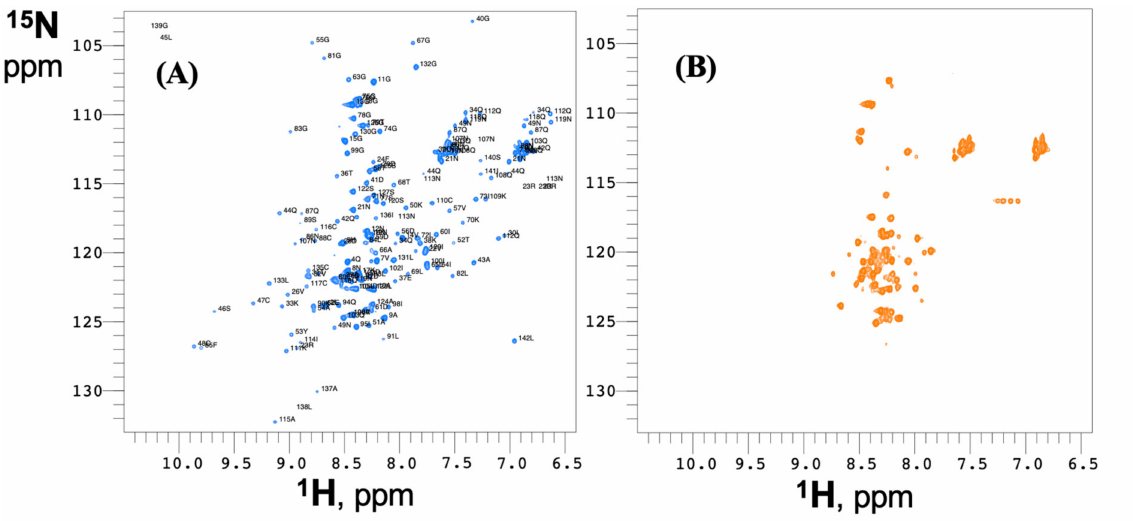
Figure 1. 1 H- 15 N correlation spectra (HSQC) spectra of ( A ) folded RodAp and ( B ) reduced RodAp. In ( A ), the residue and number of each backbone amide correlation is shown. Spectra were recorded at 25 ◦ C in 20 mM sodium acetate bu ff er (pH 4.3) with 5% D 2 O. To reduce the cysteine residues of the protein, 5 mM TCEP was added to the bu ff er.